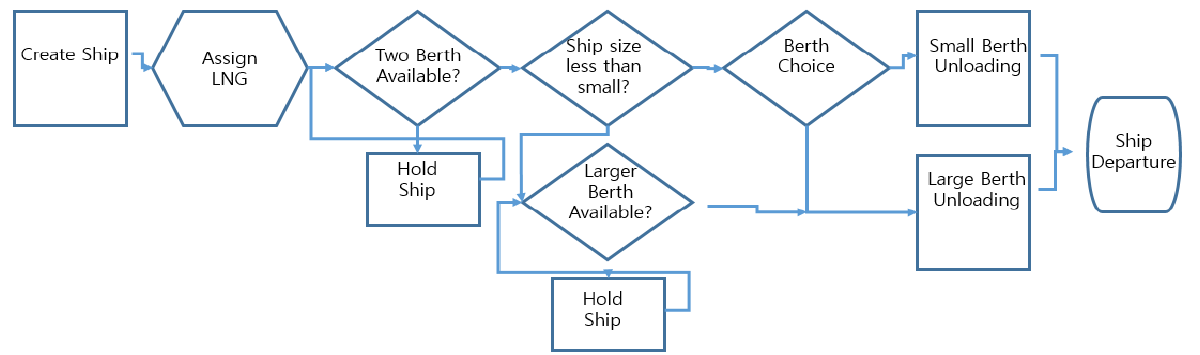
Figure 1. Simulation Model for LNG Dolphin.